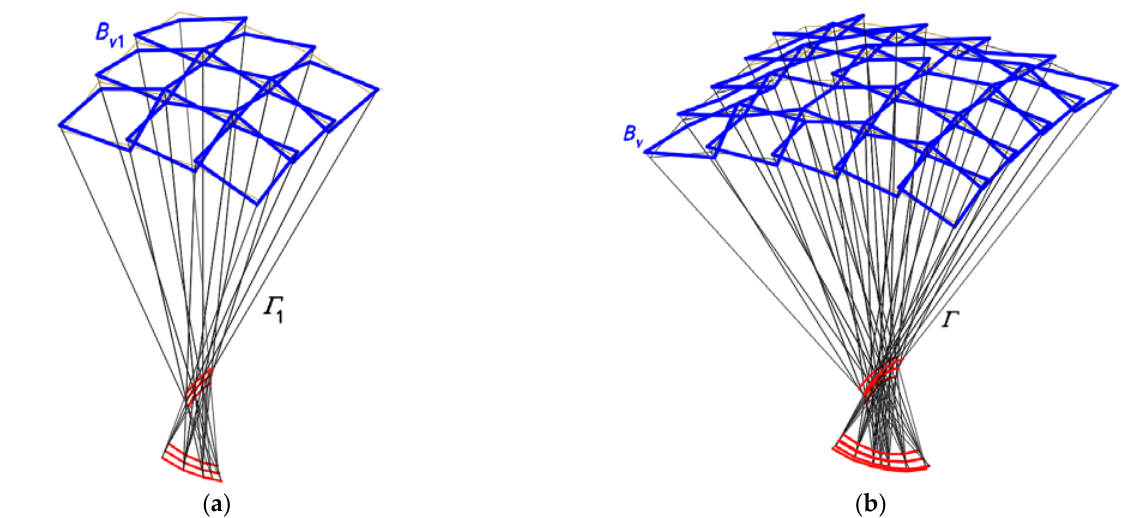
Figure 14. The polyhedral and quadrilateral nets for a discontinuous roof structure: ( a ) one-fourth of Γ 1 and B v 1 ; ( b ) entire Γ and B v .